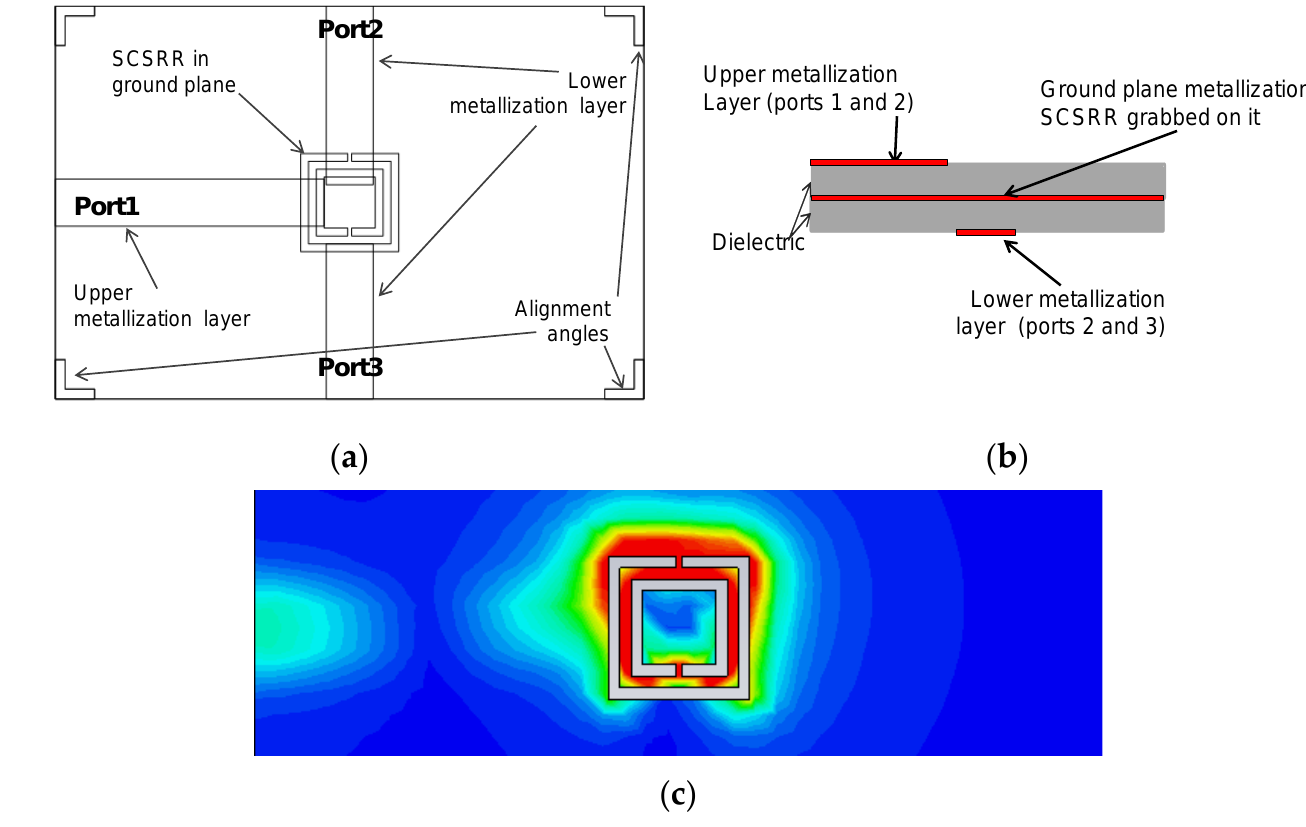
Figure 13. ( a ) Top view layer distribution of a 2-layer power divider. ( b ) Front view layer distribution. ( c ) Surface current distribution in SCSRR metallization layer at the resonant frequency.